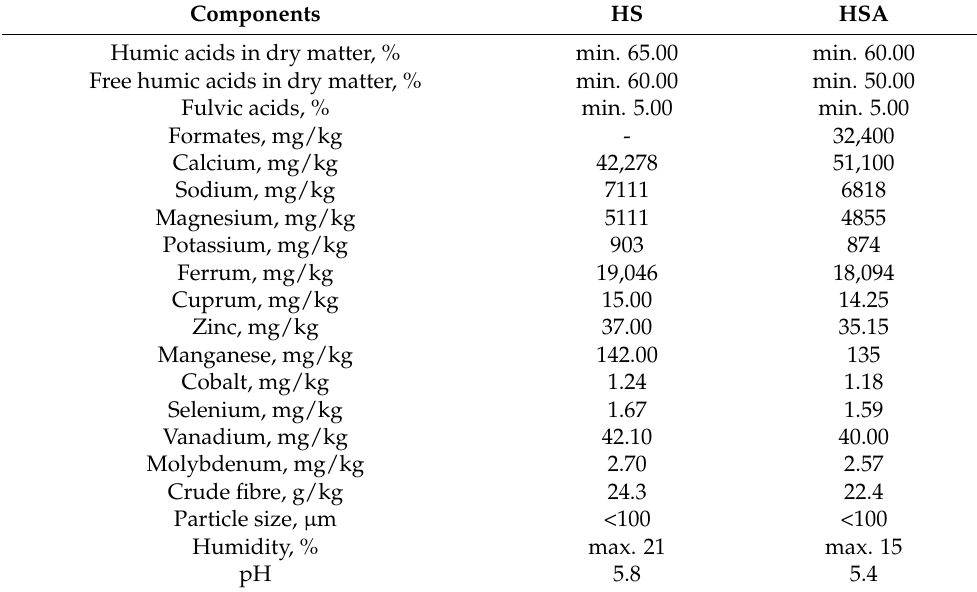
Table 1. The composition of humic substances (HS) supplements.